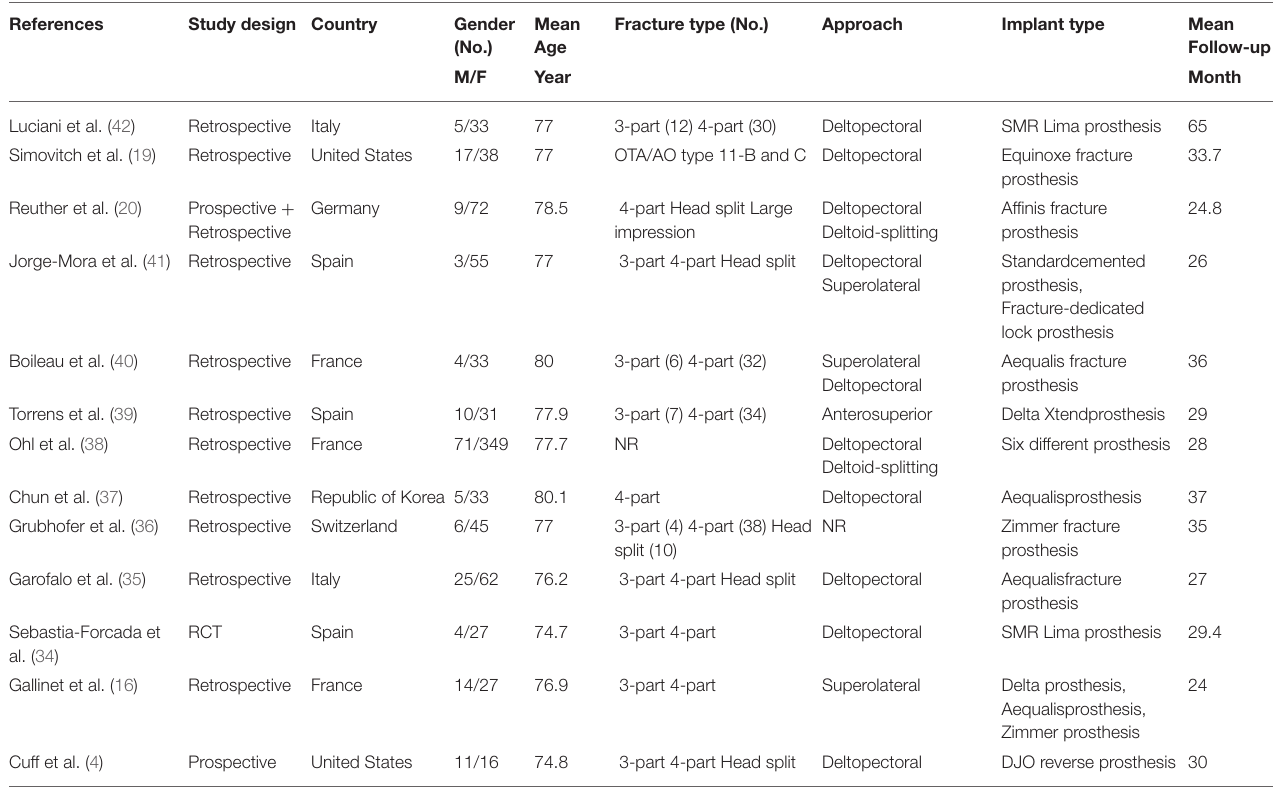
TABLE 1 | Demographic data of the included